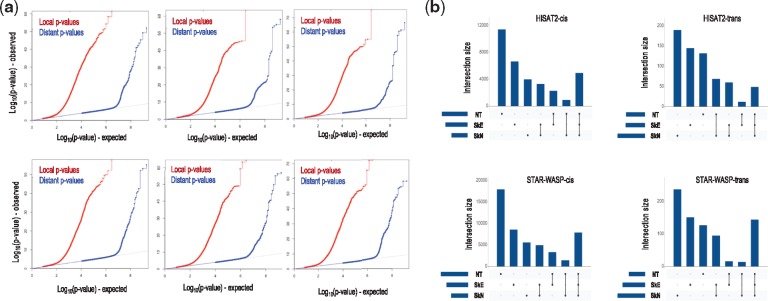
(a) QQ-plots of the ReQTL P-values: from left to right: NT, SkE, SkN, top: HISAT2 pipeline, bottom: STAR-WASP pipeline. (b) Relative representation of tissue-specific and shared ReQTLs. On each graph, the three plots on the left represent exclusive NT, SkE and SkN, ReQTLs, respectively; the 3-tissue overlapping ReQTLs are shown on the most-right